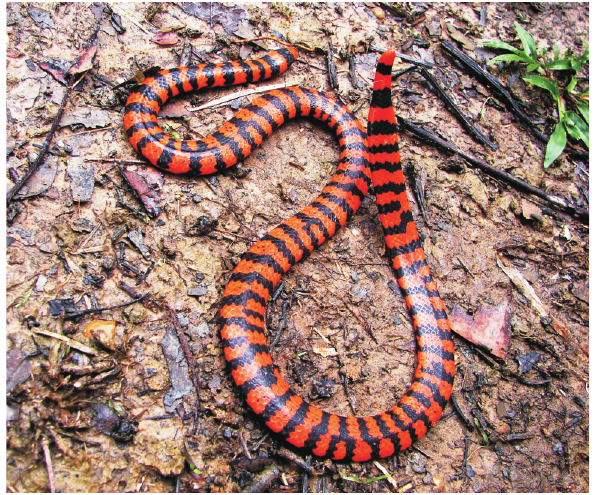
Figure 1. Dorsal view of A. scytale from Coari, state of Amazonas, Brazil, showing defense posture. Photo: G.F.